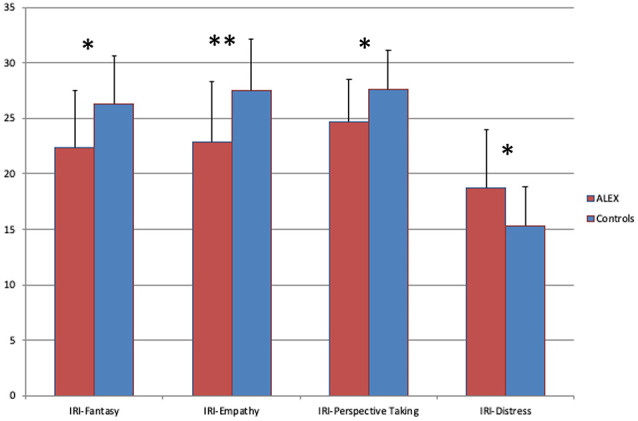
Scores of Interpersonal Reactivity Index (IRI), ALEX had lower scores on Empathy Fantasy and Perspective Taking subscales and higher on Personal Distress subscale. The Error-bars indicate standard deviation (SD). *p < 0.05, **p < 0.001. Abbreviations: ALEX, highly alexithymic individuals.